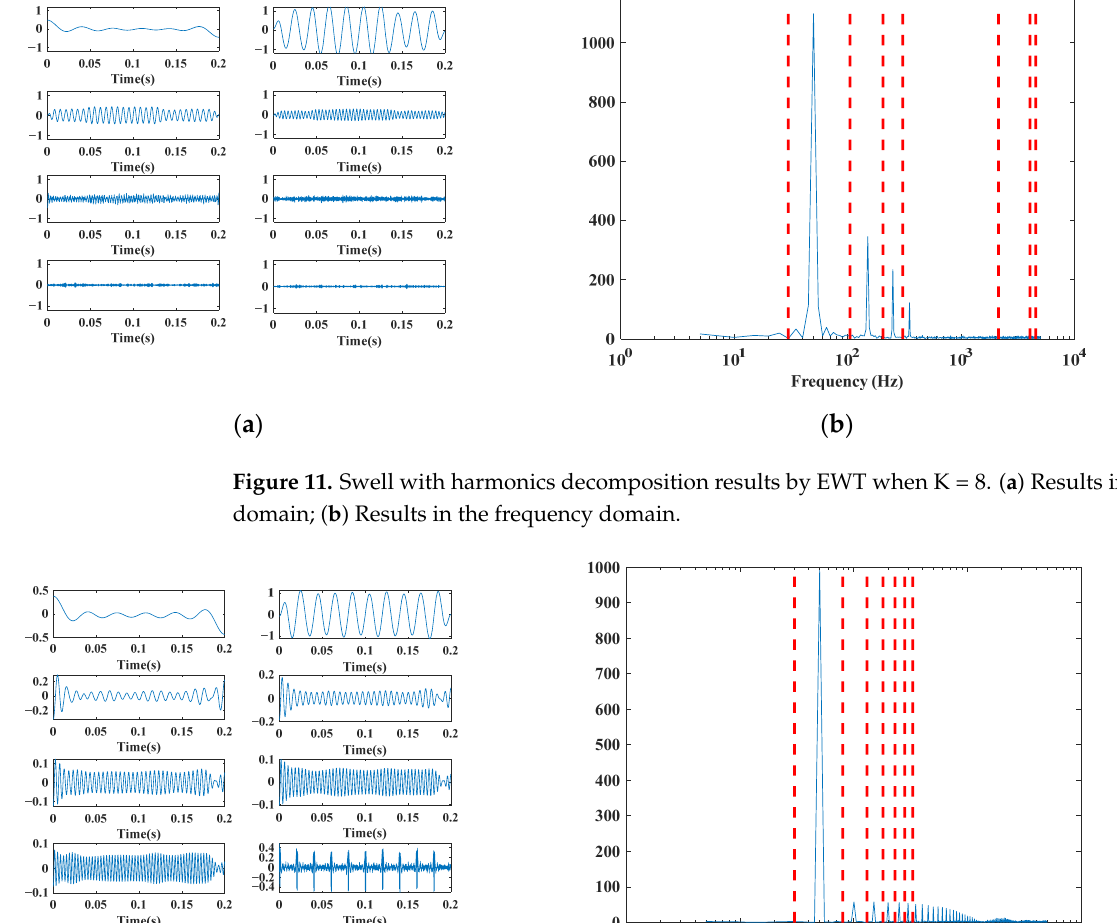
( b ) Figure 13. Recognition accuracy under different selected features. ( a ) Training result by random selection; ( b ) Training result by ReliefF selection.